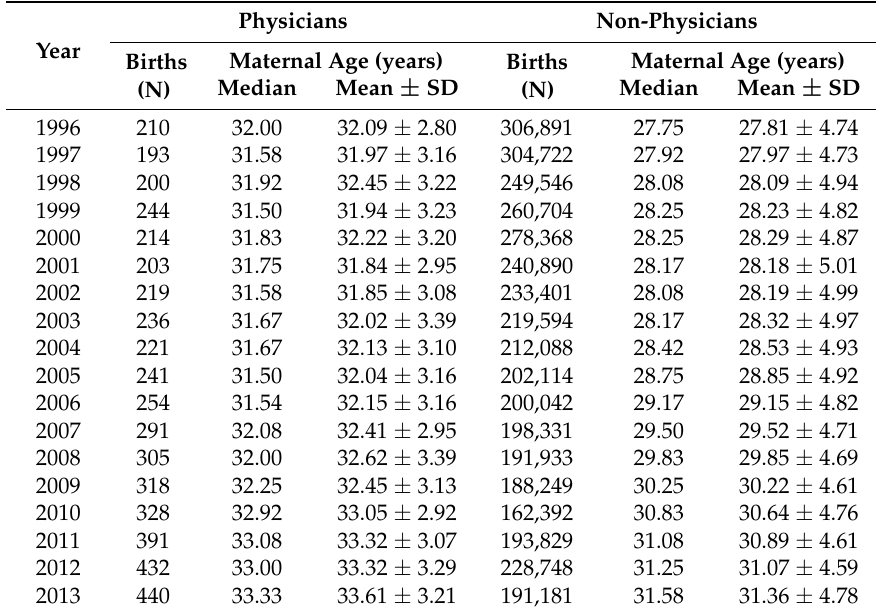
Maternal age at delivery and number of births among female physicians and non-physicians, 1996–2013.